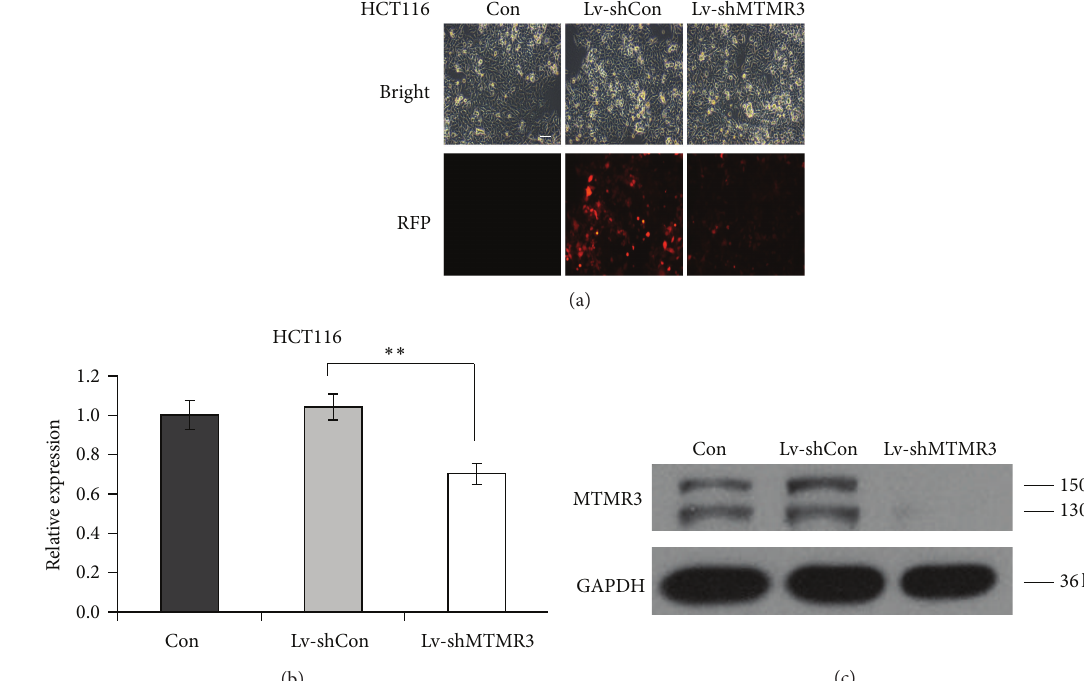
Figure1:VerificationofMTMR3silencinginHCT116cellsafterLv-shMTMR3infection.(a)Transductionefficiencywasassessedbycounting RFP-expressing cells with fluorescence microscopy (scale bar: 50 𝜇 m). (b) The mRNA levels of MTMR3 in HCT116 cells with three treatments (Lv-shMTMR3, Lv-shCon, and Con) measured by RT-qPCR. The experiment was performed in triplicate and repeated three times. (c) The protein levels of MTMR3 in HCT116 cells with three treatments (Lv-shMTMR3, Lv-shCon, and Con) measured by western blot. The experiment was repeated three times ( ∗∗ 𝑃 < 0.01